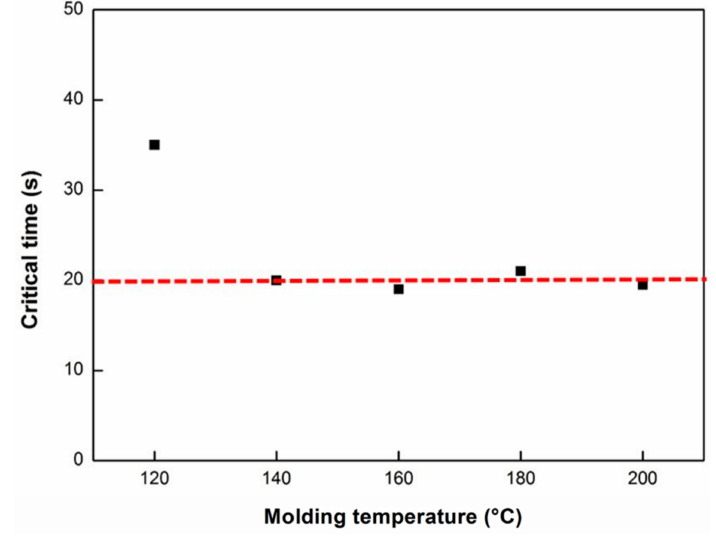
Figure 17. Critical time at di ff erent molding temperatures. Table 5. DSC diagrams of the heating